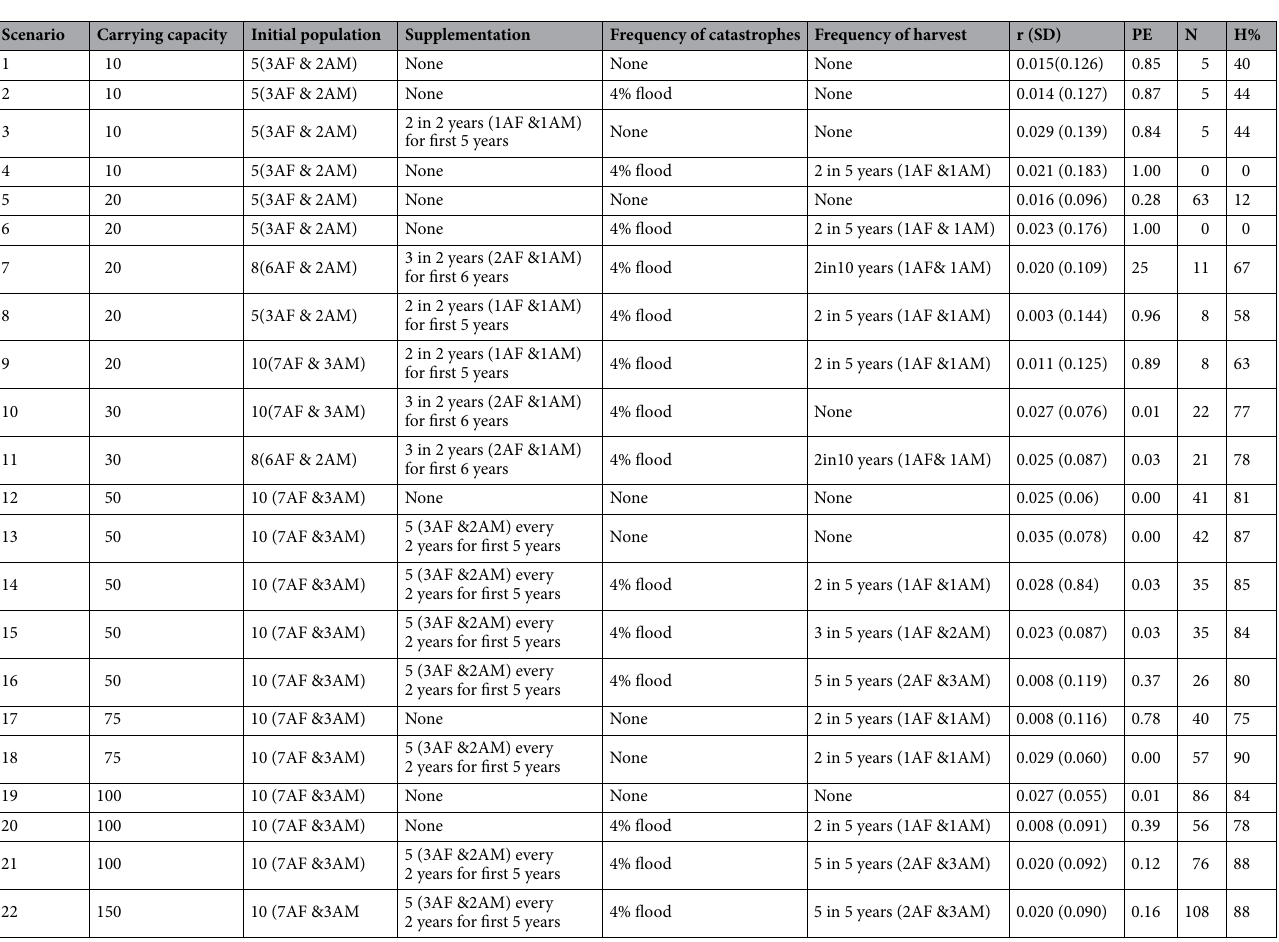
Table 2. Results of 500 simulations of population trajectories over 100 years in VORTEX (9.93) to assess the viability of greater one-horned rhinoceros populations with different scenarios of carrying capacity, poaching, catastrophe, initial population size and supplementation. Here AF – adult female, AM – adult male, r = growth rate of population, (SD) = standard deviation, N = population size at the end of 100 years, PE = probability of Extinction and H = heterozygosity of the population at the end of 100